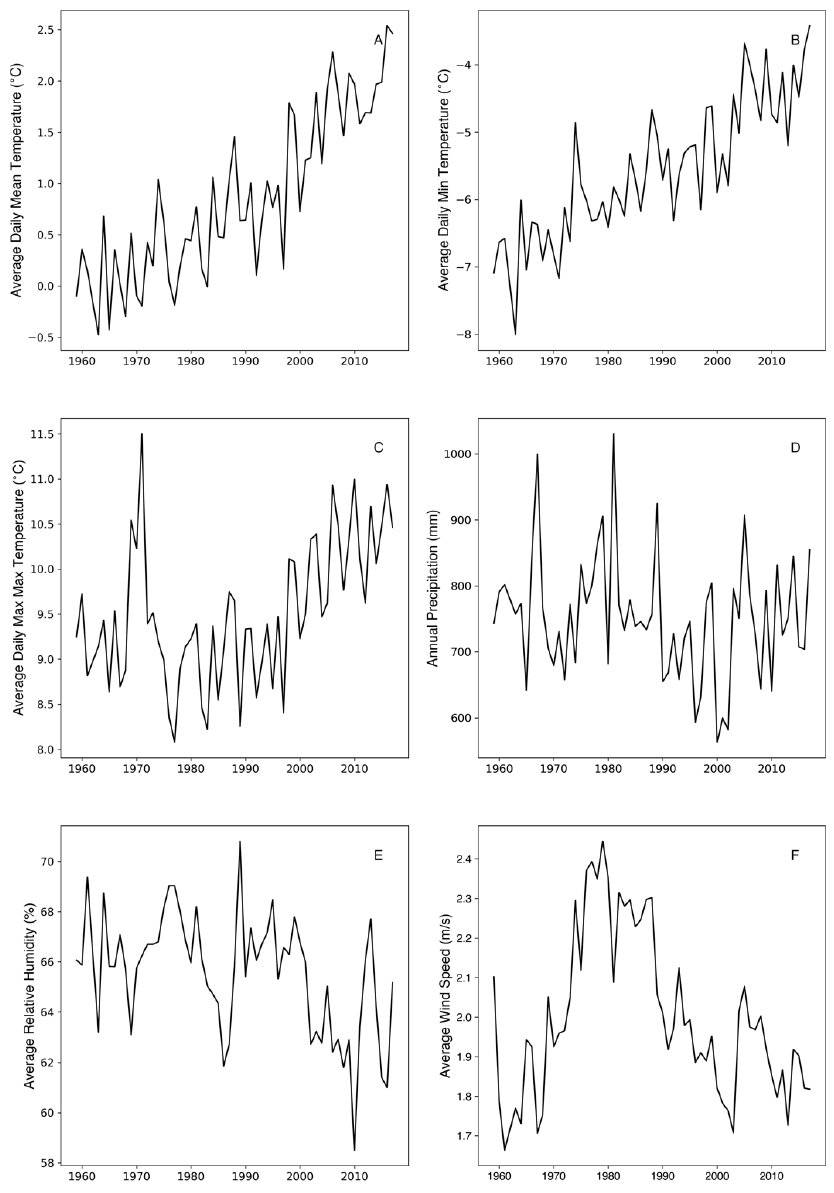
Figure 8 Time Series of Weather Data at Jiuzhi Station Figure 8. Time Series of Weather Data at Jiuzhi